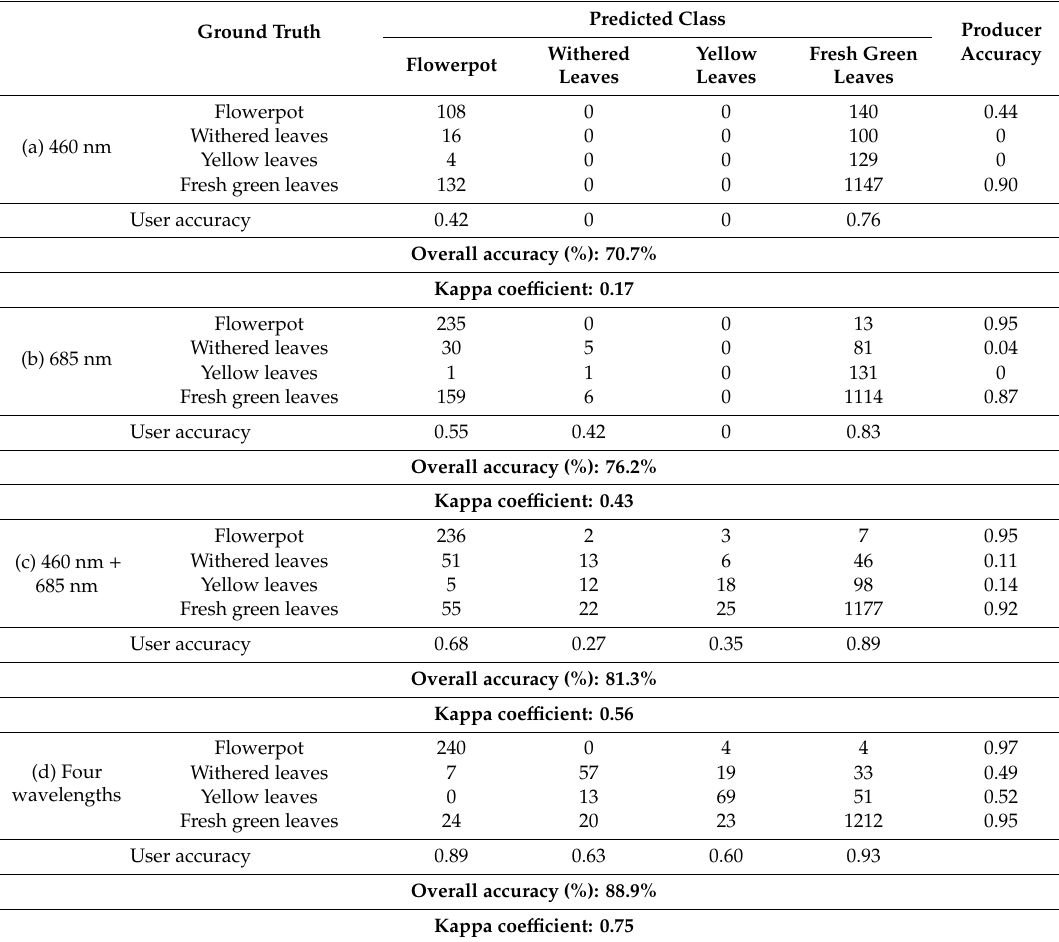
Table 2. Confusion matrices of di ff erent wavelengths’ spectrum data classification results for Scene 2 (corresponding to Figure